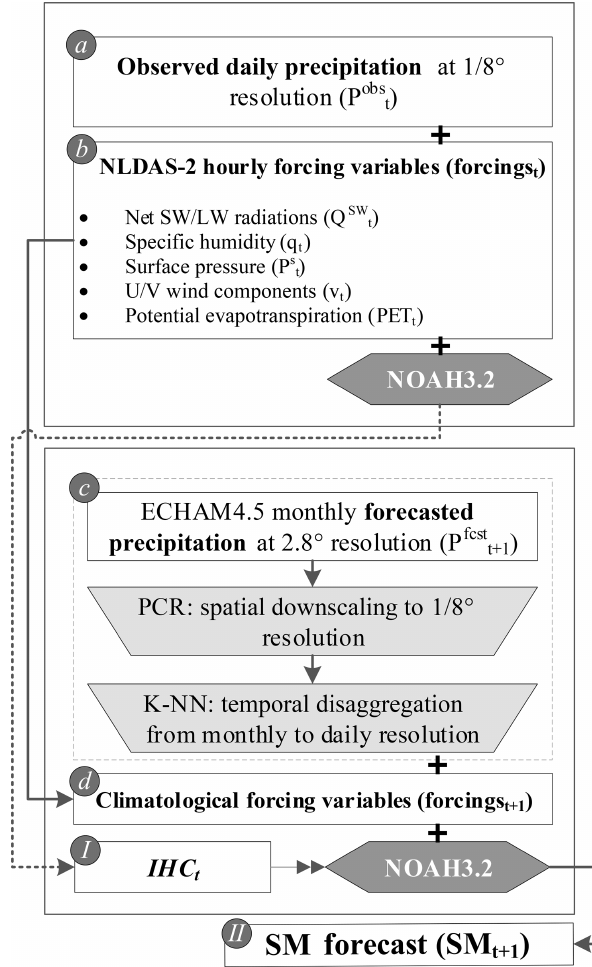
Figure 1. Soil moisture forecasting schematic. (a) Observed pre- cipitation forcings from Maurer et al. (2002) and (b) observed non- precipitation land surface forcing fields from NLDAS-2 are imple- mented into NOAH3.2 LSM to simulate (I) the initial hydrologic conditions (IHCs) prior to each forecasting period. The IHCs are then used along with (c) 1- to 3-month-ahead ECHAM4.5 precipita- tion forecasts (spatially downscaled and temporally disaggregated, see Sect. 2.1) and (d) climatological forcings (i.e., mean of NLDAS- 2 nonprecipitation forcings over the period 1979–2010), in order to execute NOAH3.2 LSM under a forecasting scheme and to develop (II) 1- to 3-month-ahead soil moisture